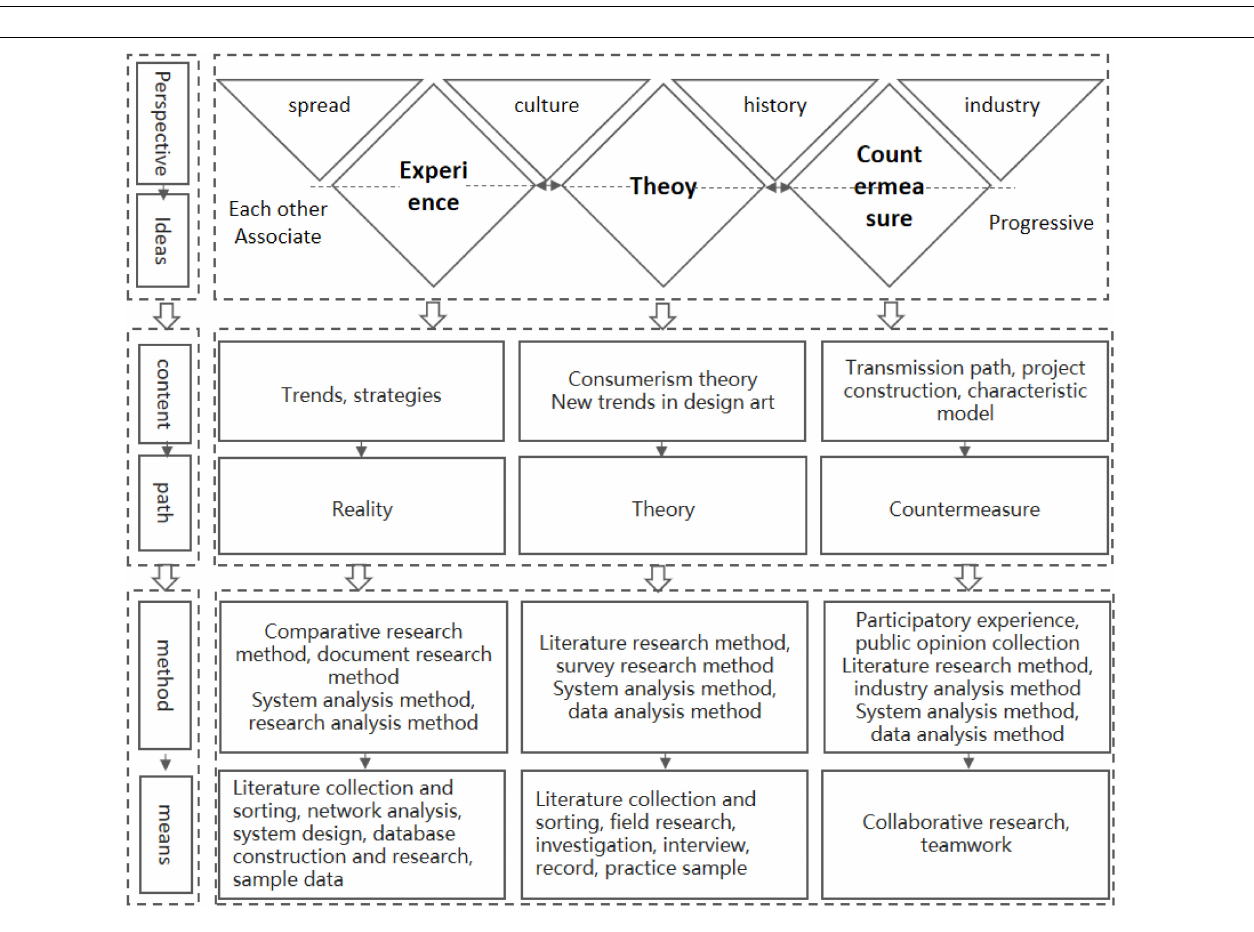
FIGURE 3 | Design project process import.